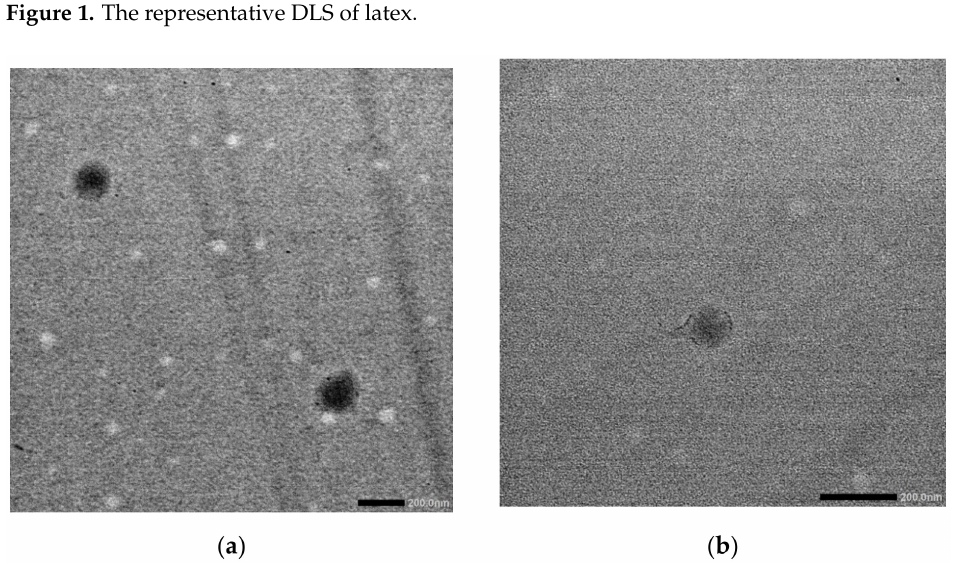
Figure 2. TEM images of latex particles ( a ) CS4, ( b )